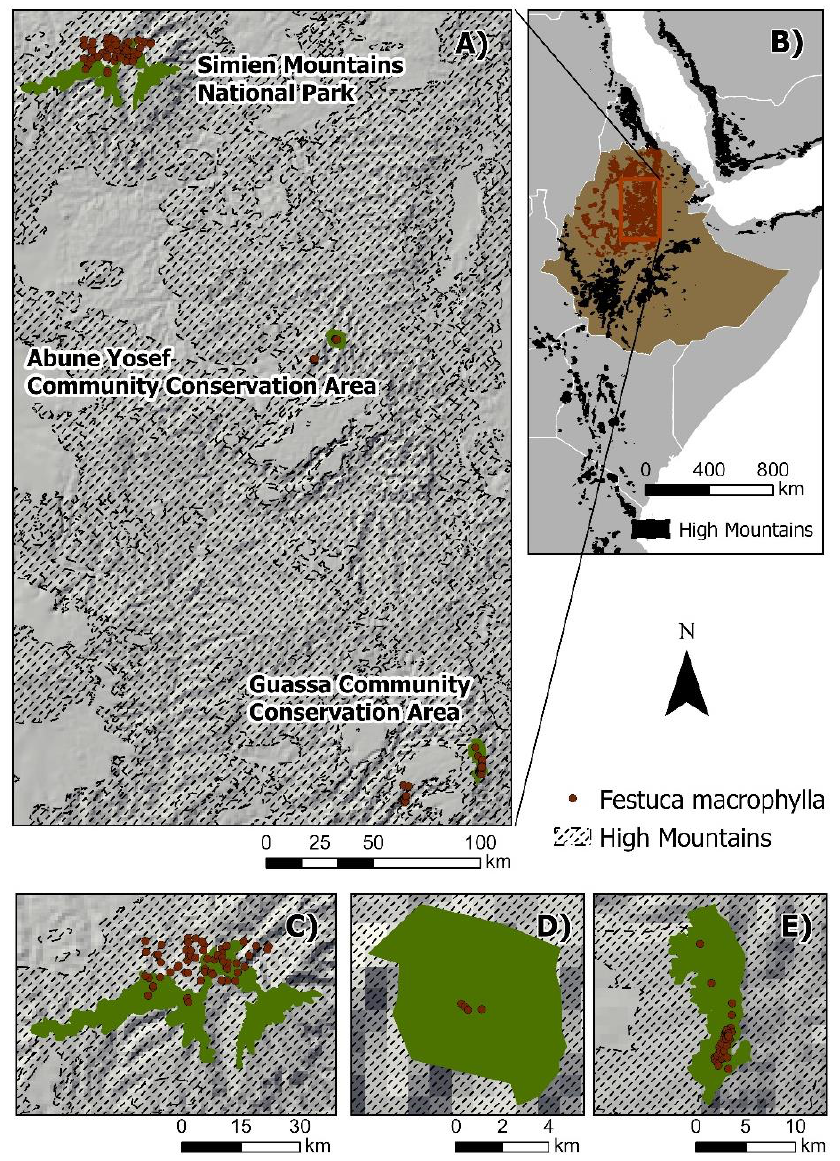
Figure 1. Map depicting ( A ) three protected areas where guassa grass ( F. macrophylla ) is currently found, ( B ) the location of these areas in the country of Ethiopia and the broader Horn of Africa context, ( C ) the distribution of guassa grass observations in Simien Mountains National Park, ( D ) the distribution of guassa grass observations in Abune Yosef Community Conservation Area, and ( E ) the distribution of guassa grass observations in Guassa Community Conservation Area.